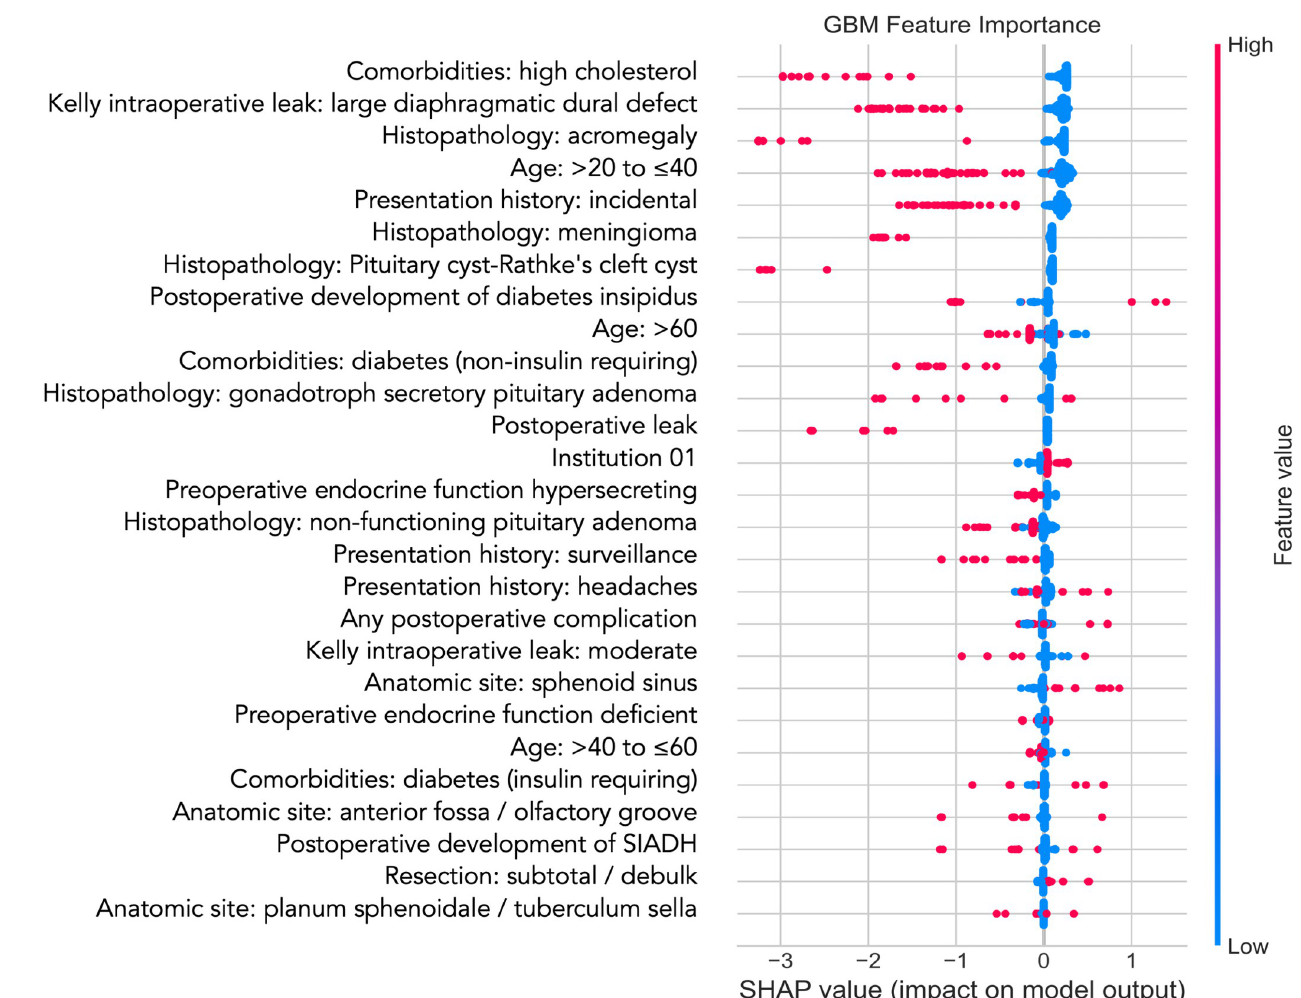
Fig 3. Gradient boosting machine (GBM) feature importance. SHAP, Shapley additive explanations. SIADH, syndrome of inappropriate antidiuretic hormone